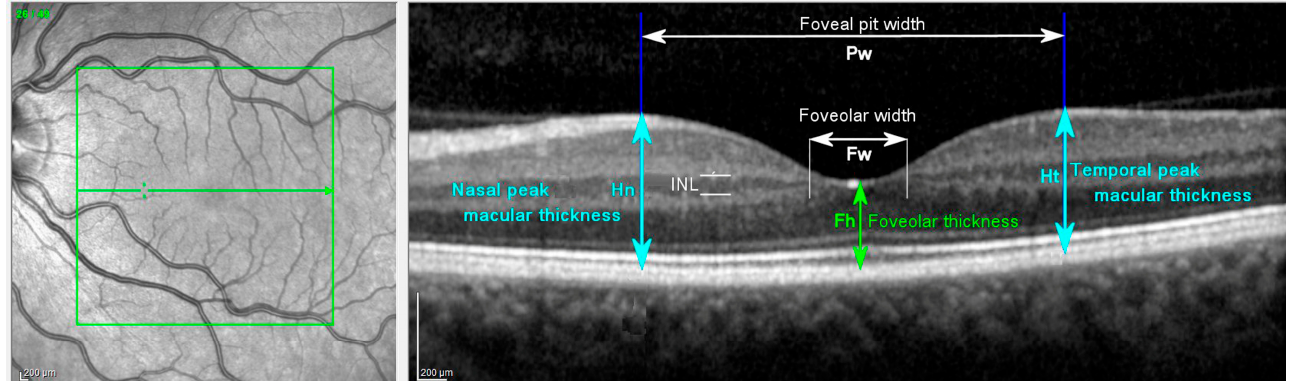
Figure 3. Definitions of foveal and foveolar morphology. Participant 41 left eye. Left panel is an infrared scanning laser ophthalmoscope fundus image with a superimposed 20° square box and bisecting horizontal arrow that runs through the foveolar centre. Right panel is the OCT image scanned along the horizontal arrow in the SLO image. Annotations are: INL, inner nuclear layer of retina (section between horizontal thin white lines); Fh foveolar thickness (central macular thickness, light green); Fw foveolar width (white horizontal arrow) is the distance between adjacent terminations of the INL (thin vertical white lines); Hn, nasal peak macular thickness (light blue); Ht temporal peak macular thickness (light blue); Pw, foveal pit width. The foveal pit height (Ph) is calculated as the difference between Fh and the average of Hn and Ht. The foveolar radius (Fr) and foveal pit radius (Pr) are half the respective widths measured in degrees of visual angle. Scale bars are in μ m (machine values). The horizontal width of the OCT scan is 20° of visual angle.